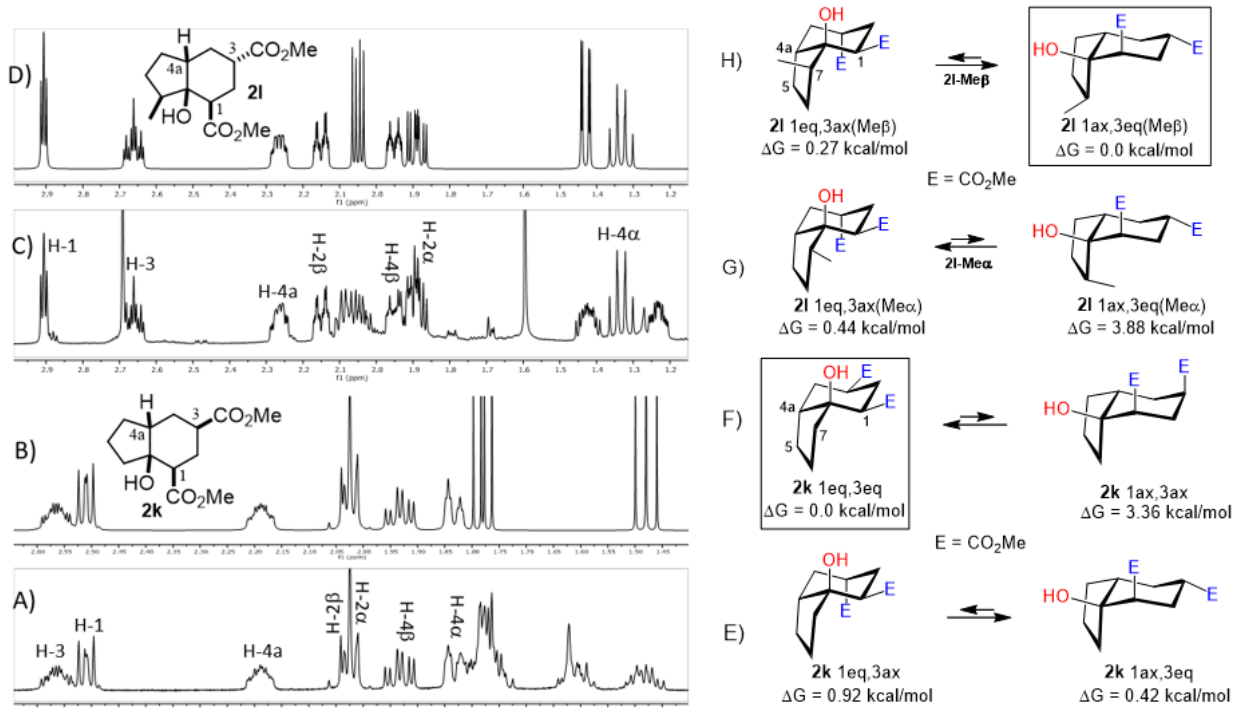
Figure 7. Experimental ( A , C ) and simulated ( B , D ) 1 H NMR spectra of hydrindanes cis - 2k and cis - 2l , respectively. Full 1 H NMR simulated parameters were considered only for the shown protons. ( E – H ) show the relative energies of conformers for cis -hydrindanes 2k and 2l , respectively, which illustrate the conformational influence of CO 2 Me and Me groups attached at C-3 and C-7, respectively. Structures inside rectangles belong to the most stable conformers.